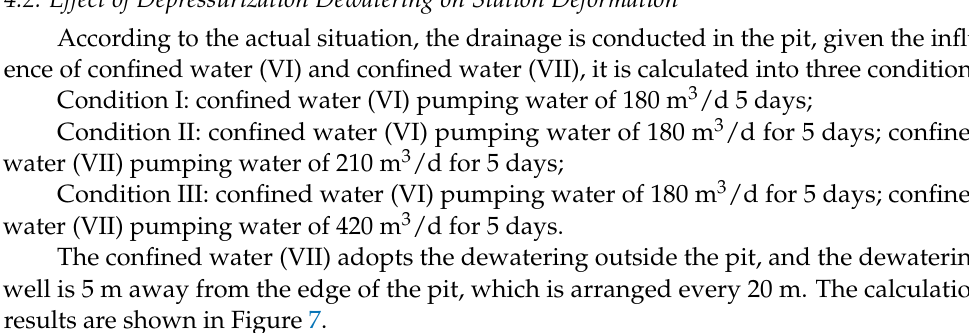
Figure 6. Cumulative deformation of earthwork excavation station.